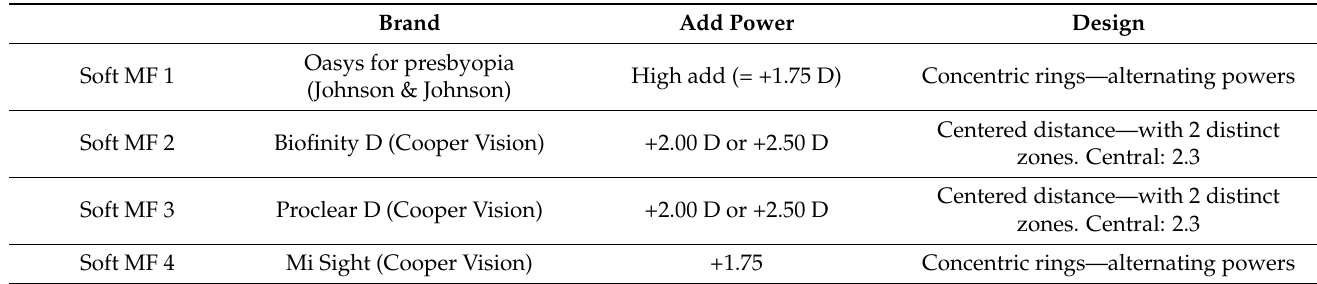
Table 2. Lens variants description, soft multifocal lenses.